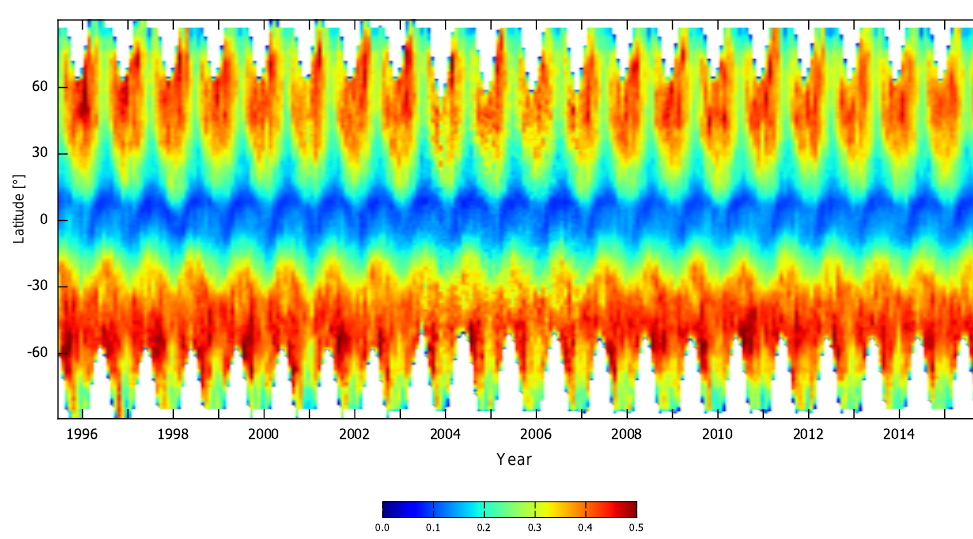
Figure D2. Relative SD ( σ/V ) averaged over longitude as a function of time and latitude.